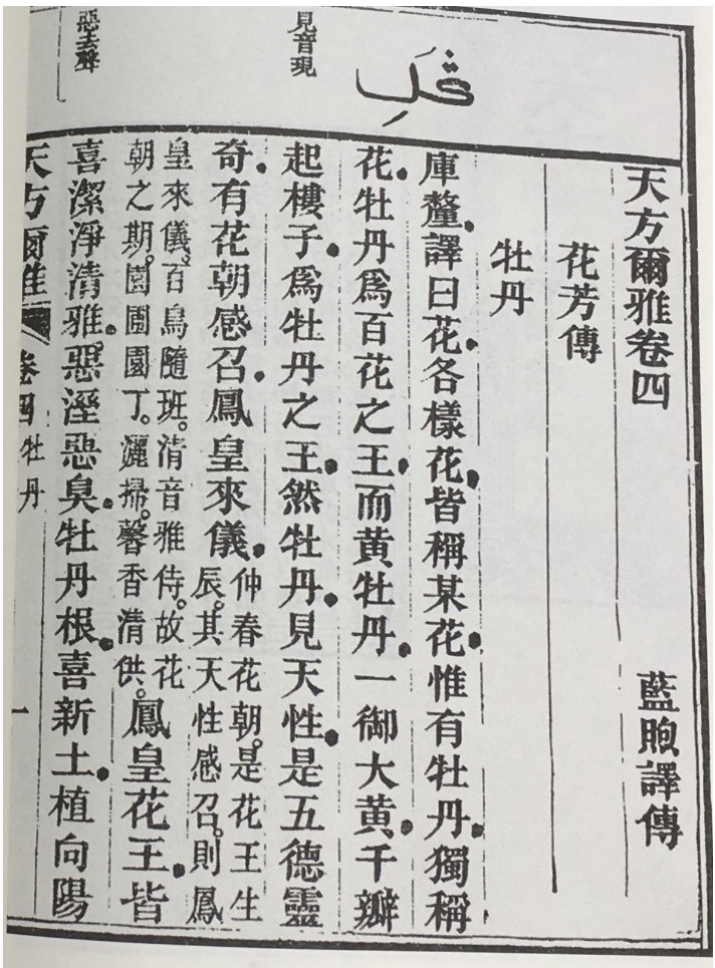
Figure 7. One Page of Tianfang Erhya of Lanxu. Lanxu wrote the Persian word “gol” and its Chinese interpretation as peony on this page. The first letter “g” was not written in a proper style, as in modern